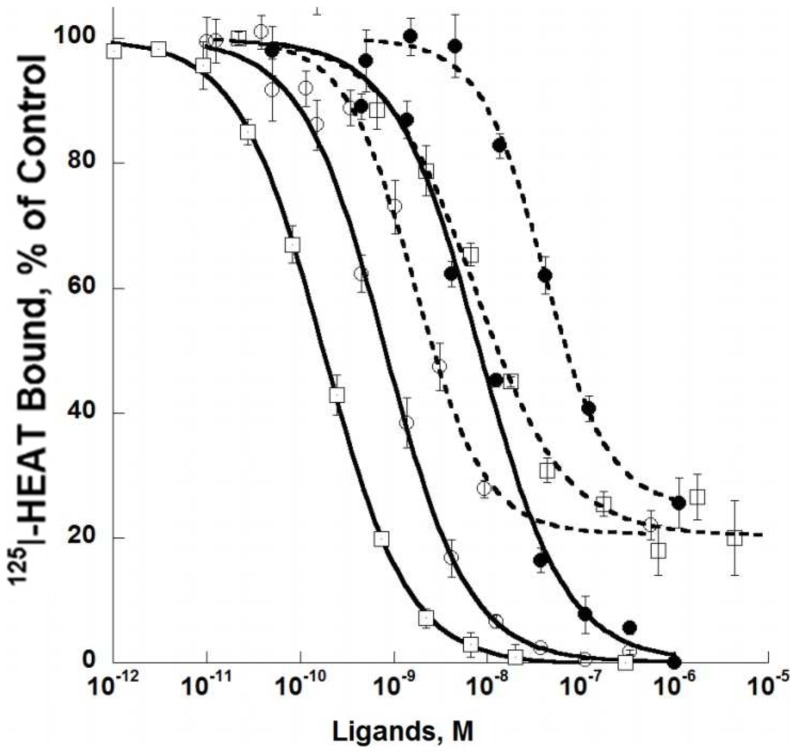
Receptor affinities for ρ-Da1a (dash lines) and HEAT (solid lines) on mutated α1A-ARs.Binding inhibition curves for 125I-HEAT binding to WT (200 pM, 0.2 µg, ○), D1063.32A (200 pM, 1 µg, □) and F862.64A (1.3 nM, 0.8 µg, •) receptor variants. n = 3–4.